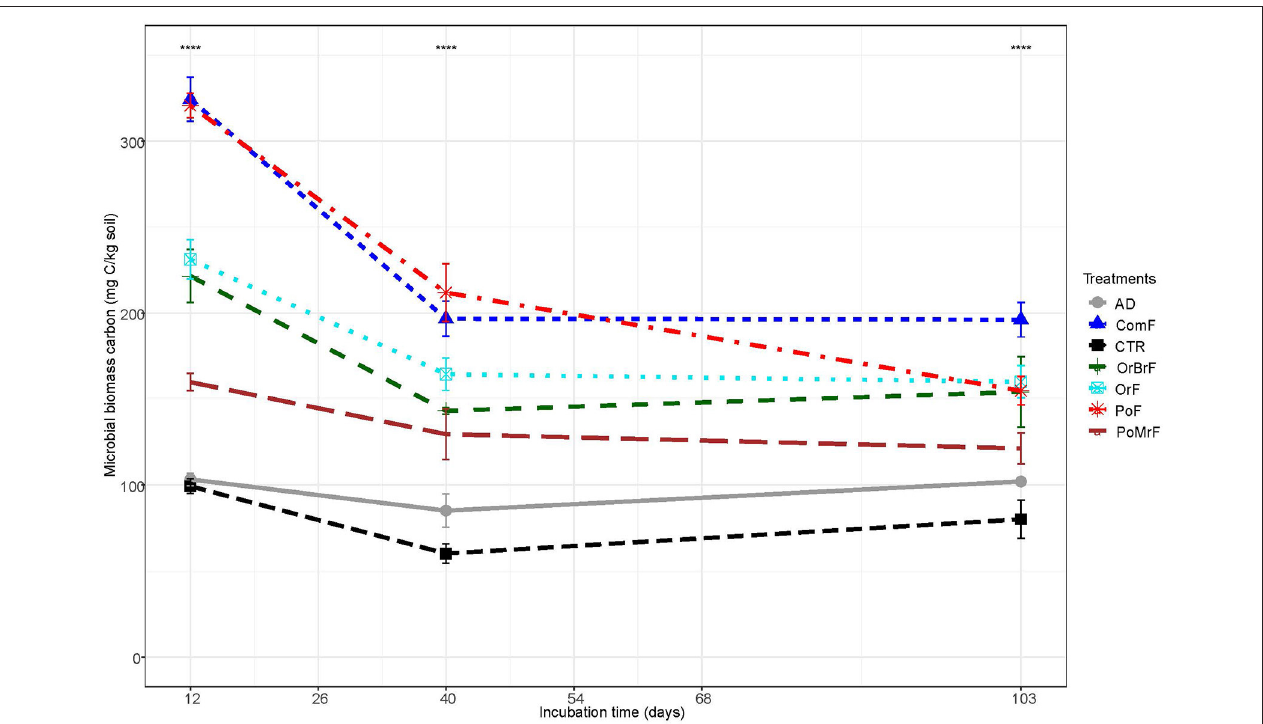
FIGURE 4 | Dynamics of microbial biomass C overtime during the incubation experiment under laboratory conditions. **** refers to significant statistical differences ( p <